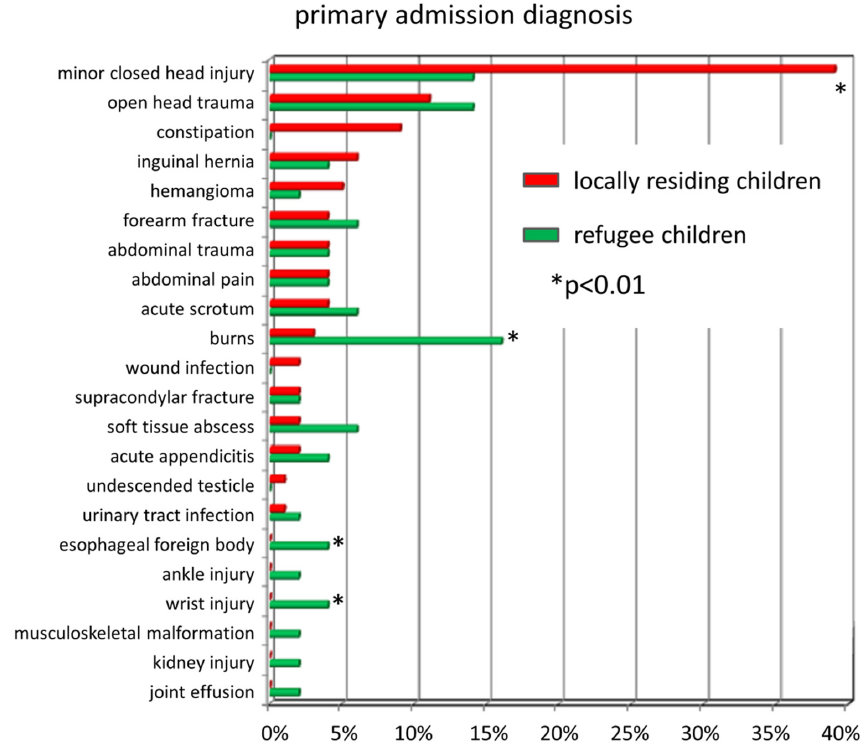
Figure 4. Relative proportion of admission diagnoses of refugee children (in green) and locally residing patients (in red) admitted to pediatric surgery from January 2005 until December 2015. While minor closed head injuries were more common in locals, refugees were more likely to be diagnosed with